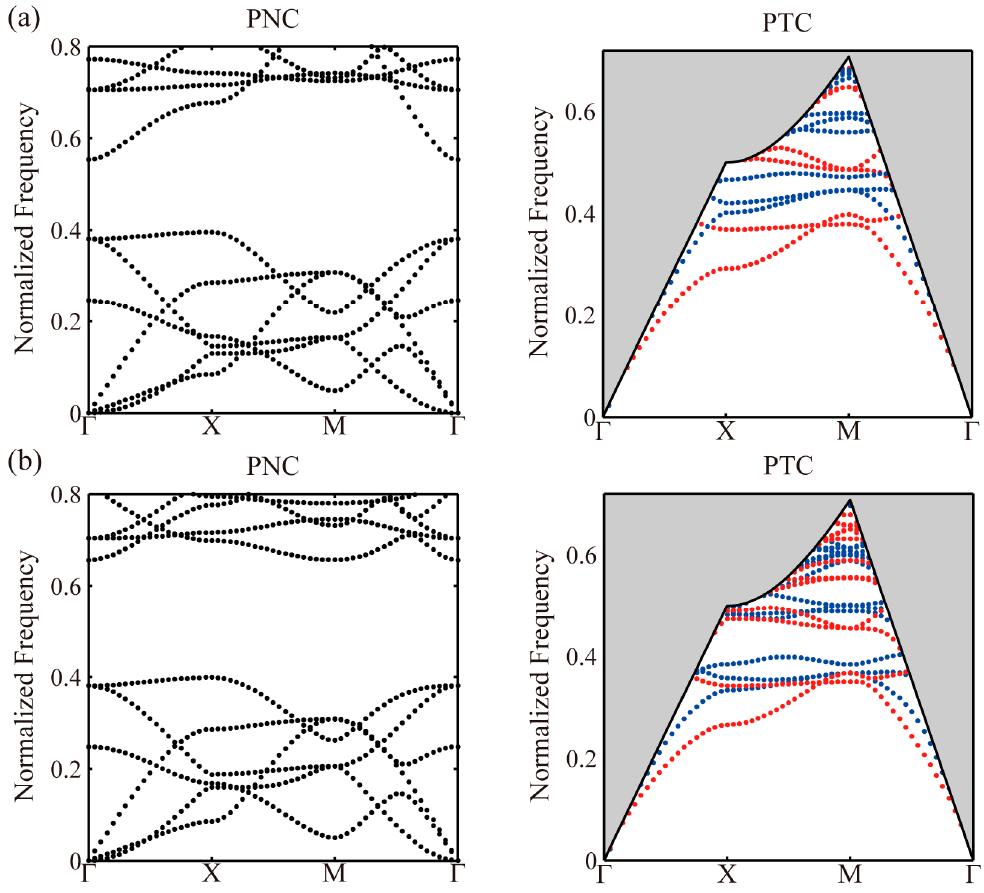
Figure 3. Band structures of phononic and photonic modes, where the geometrical parameters are r = 0.35 a , w = 0.9 a , ( a ) t = 0.4 a, and ( b ) t = 0.6 a . Red and blue dotted lines denote the photonic even and odd modes, respectively.